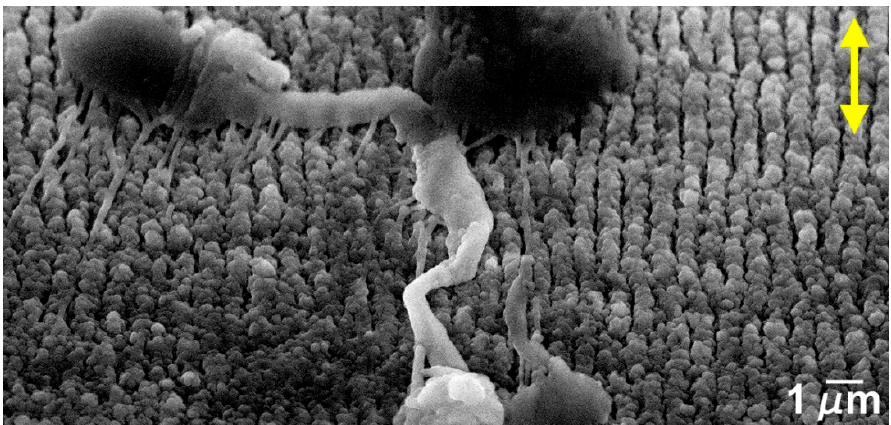
Figure 13. SEM micrograph of the cross-section of a wear track taken at 45° tilt. The double arrow indicates the sliding direction.